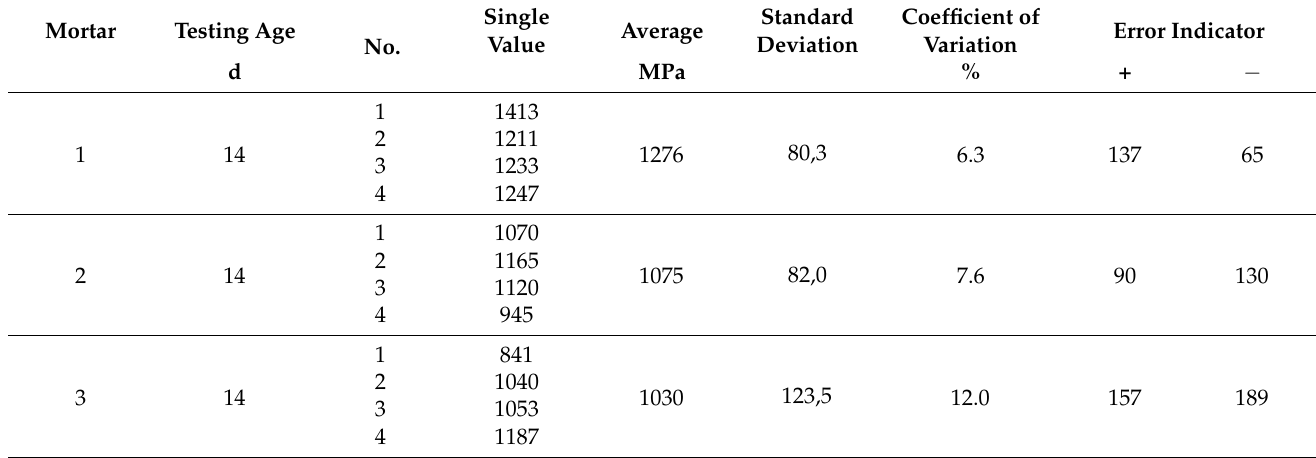
Table A3. Maximal uniaxial tension, glass textile, Mortar 1–3.